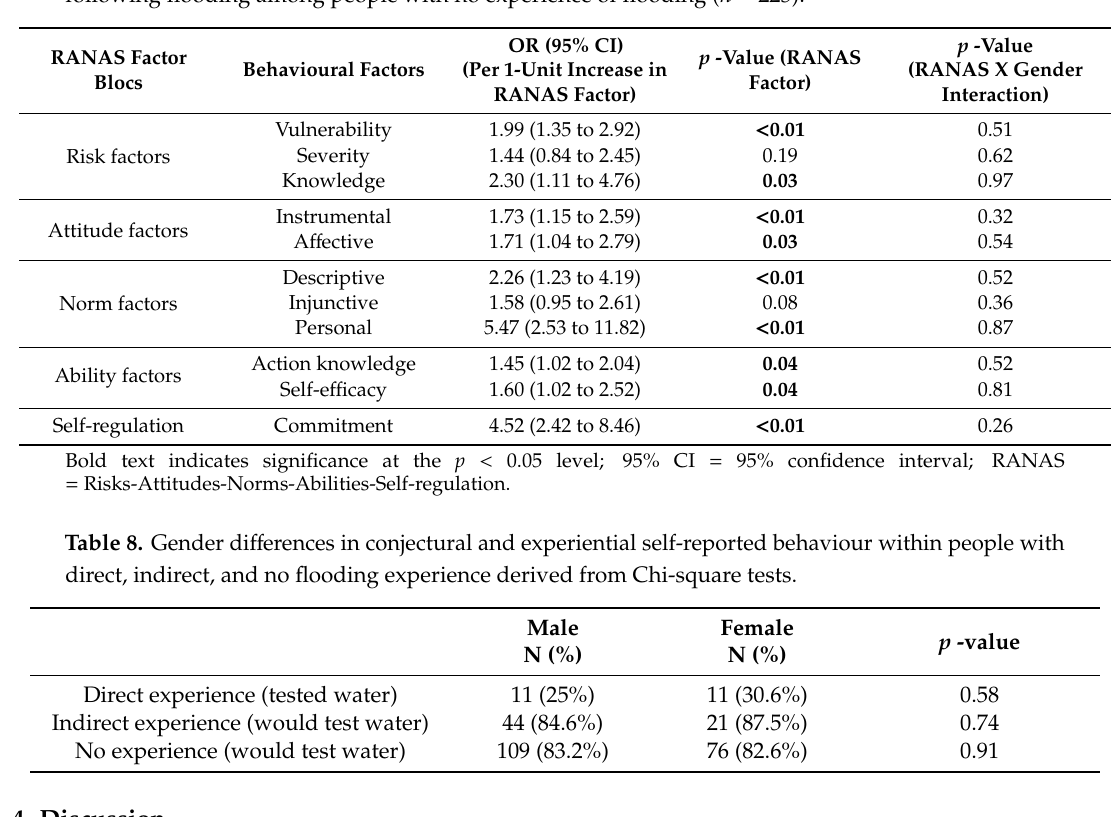
Table 7. Odds ratios (OR) and 95% confidence intervals (CI) derived from binominal logistic regression analyses as indicators of associations between RANAS components and conjectural health behaviours following flooding among people with no experience of flooding ( n = 223).